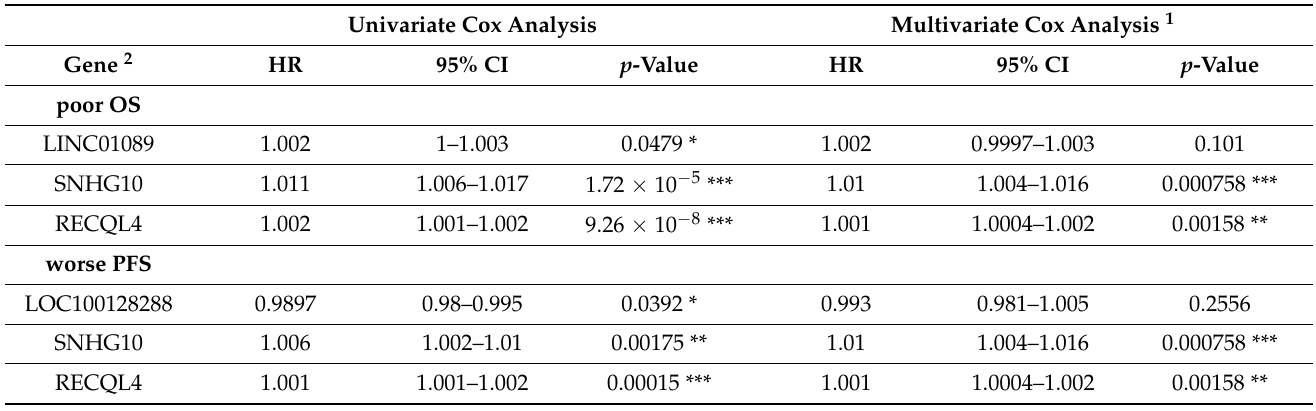
Table 2. Univariate and multivariate Cox analyses of SigIQvar8 component genes in predicting ACC poor OS and